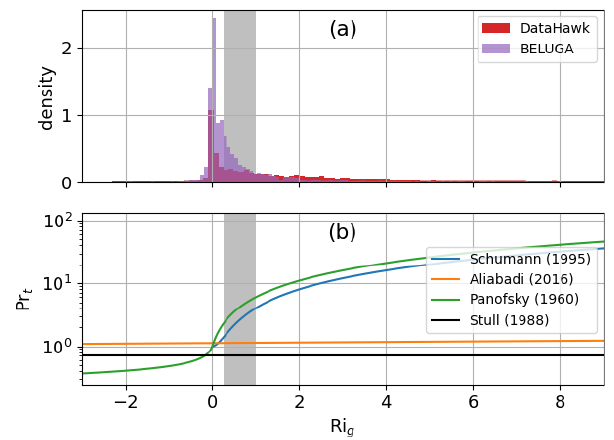
Figure 7. Histograms of (a) all measured gradient Richardson num- bers Ri g for BELUGA and DH2 for flights on 13 July and (b) dif- ferent parameterizations for Pr t = f ( Ri g ) . The range of critical Richardson numbers is shown using gray